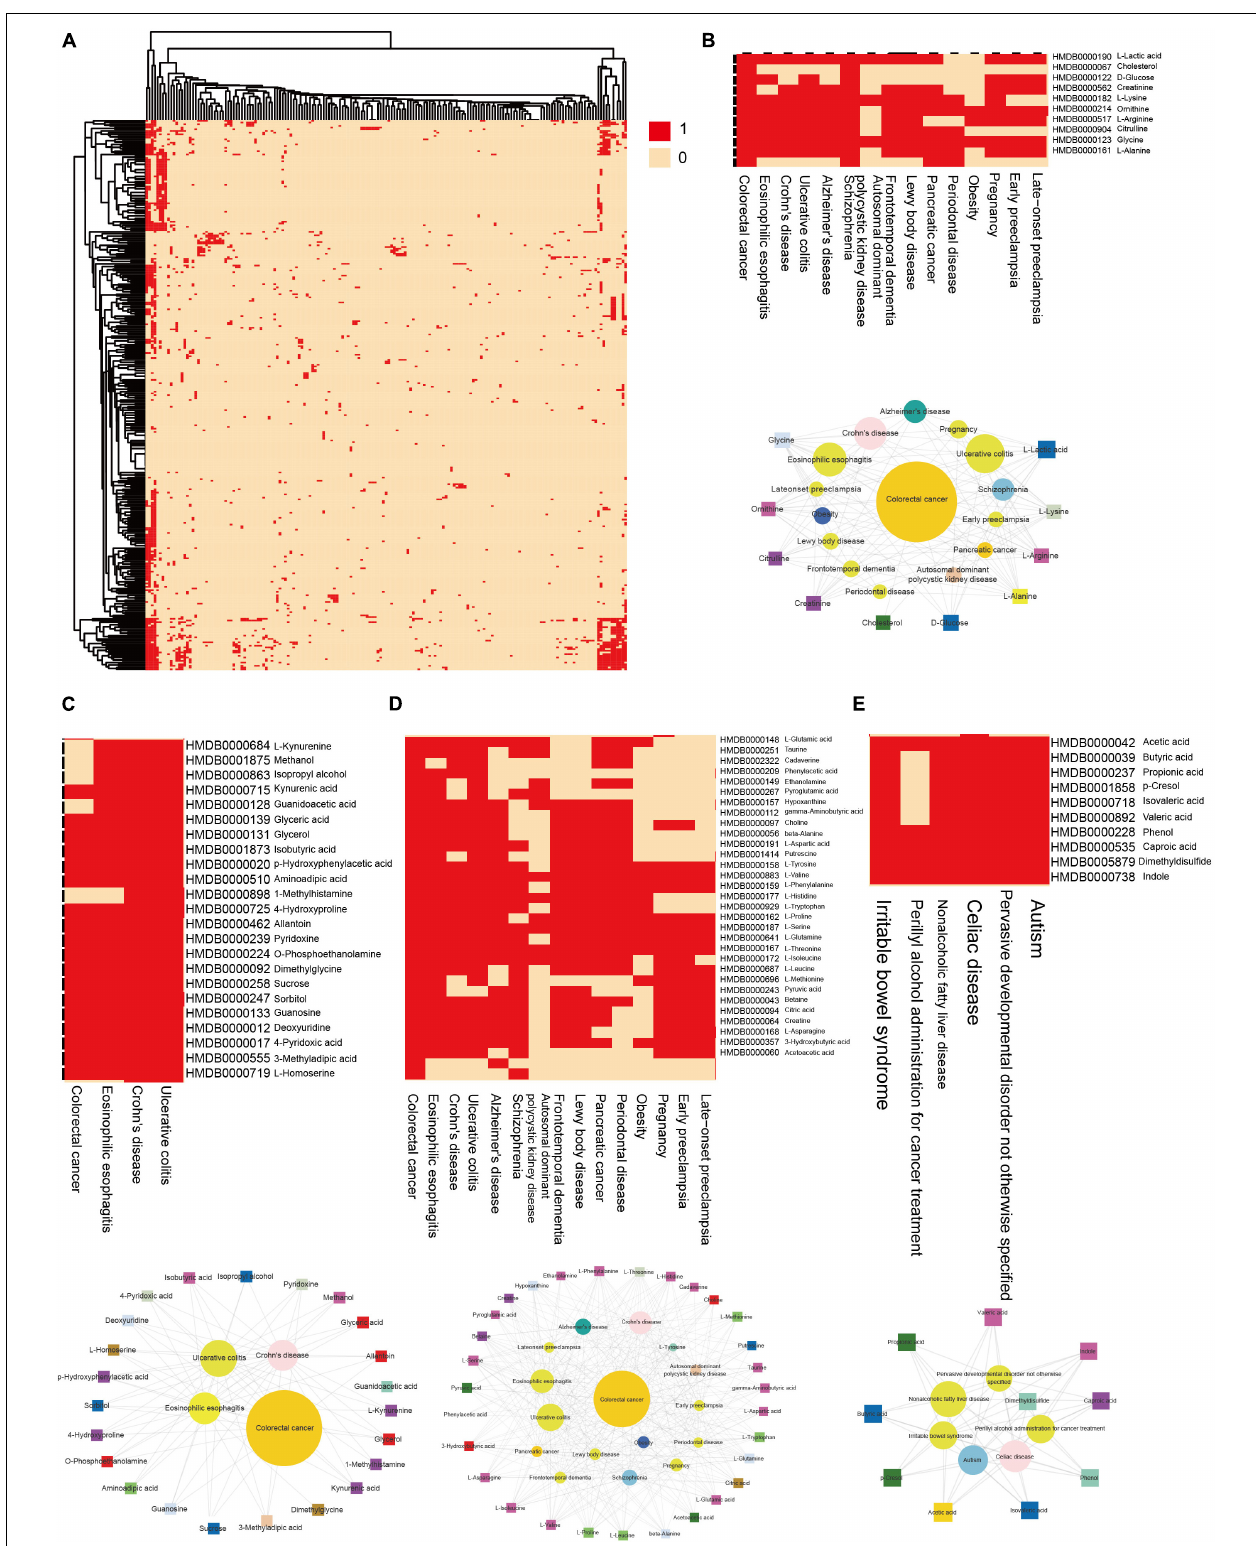
FIGURE 3 | Hierarchical clustering on the HDMN and functional modules. (A) Hierarchical clustering of network hub nodes. The corresponding cell was colored red if there was an edge between the disease and metabolite in the HDMN. (B–E) Zoom-in plot showing some closely related functional modules.